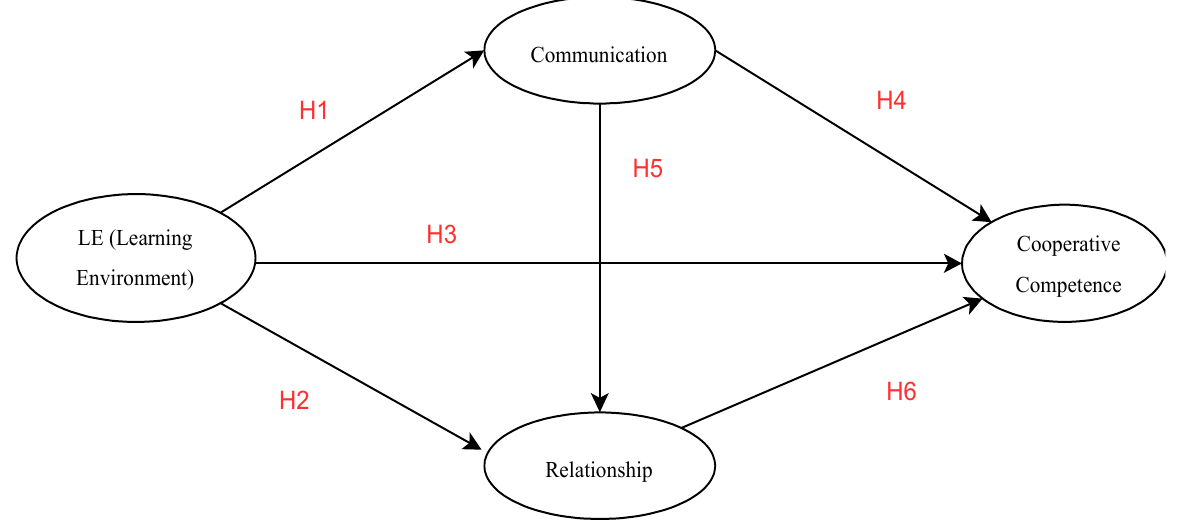
Table 3. Discriminant validity matrix (HTMT), R 2 y Q 2 results.